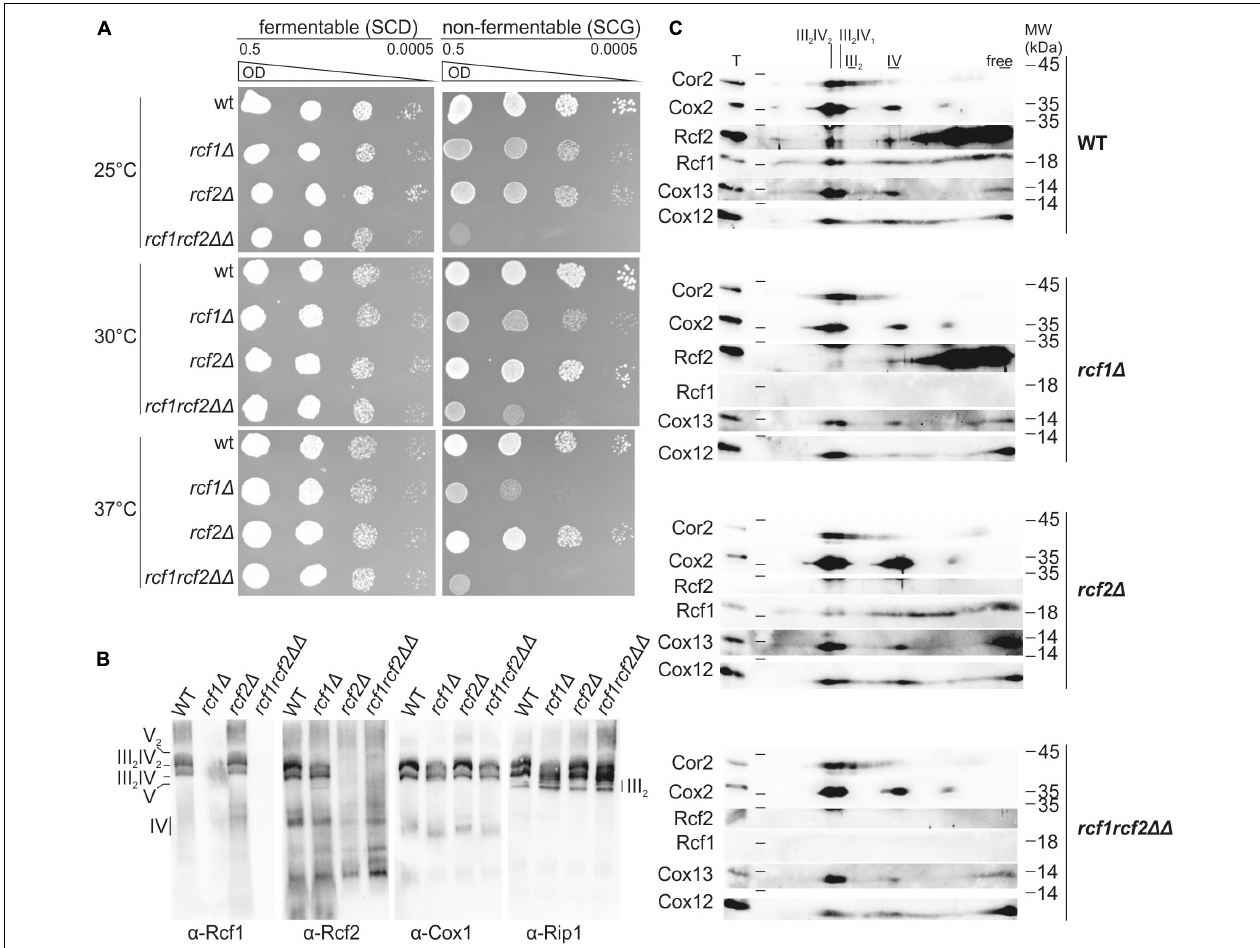
FIGURE 1 | Rcf1 and Rcf2 affect respiratory growth but influence supercomplex assembly only slightly. (A) A 10-fold serial dilution growth assay on fermentable and non-fermentable medium at different temperatures showed that absence of Rcf1 decreases respiratory ability of the strains. The absence of Rcf2 showed only in combination with loss of Rcf1 a strong decrease in growth. (B) Mitochondria were purified from cells grown to logarithmic phase in YPGal (30 ◦ C). Supercomplex assembly of mitochondria solubilized in 2% digitonin was analyzed by BN-PAGE followed by subsequent Western blot and immuno decoration showing supercomplex assembly in the absence of Rcf1 and Rcf2. The antibody against Rcf2 shows unspecific binding in the lower molecular weight range. (C) Respiratory chain complex assembly of mitochondria purified from cells grown in YPGal (logarithmic phase, 30 ◦ C) was analyzed. Mitochondria were solubilized in 2% digitonin, separated by BN-PAGE followed by separation on 2D polyacrylamide gels and Western blot analysis. Rcf1 and Rcf2 comigrate with supercomplexes. Upon loss of Rcf1, Rcf2 shifts mostly out of the supercomplexes. Still Rcf1 and Rcf2 can associate with supercomplexes in the absence of the respective other protein. Supercomplexes can still assemble in the absence of Rcf1, Rcf2 or both proteins combined although in a lower amount. T, total; III 2 IV 2 , III 2 IV, forms of supercomplexes; III 2 , dimer of bc 1 complex; IV, cytochrome c